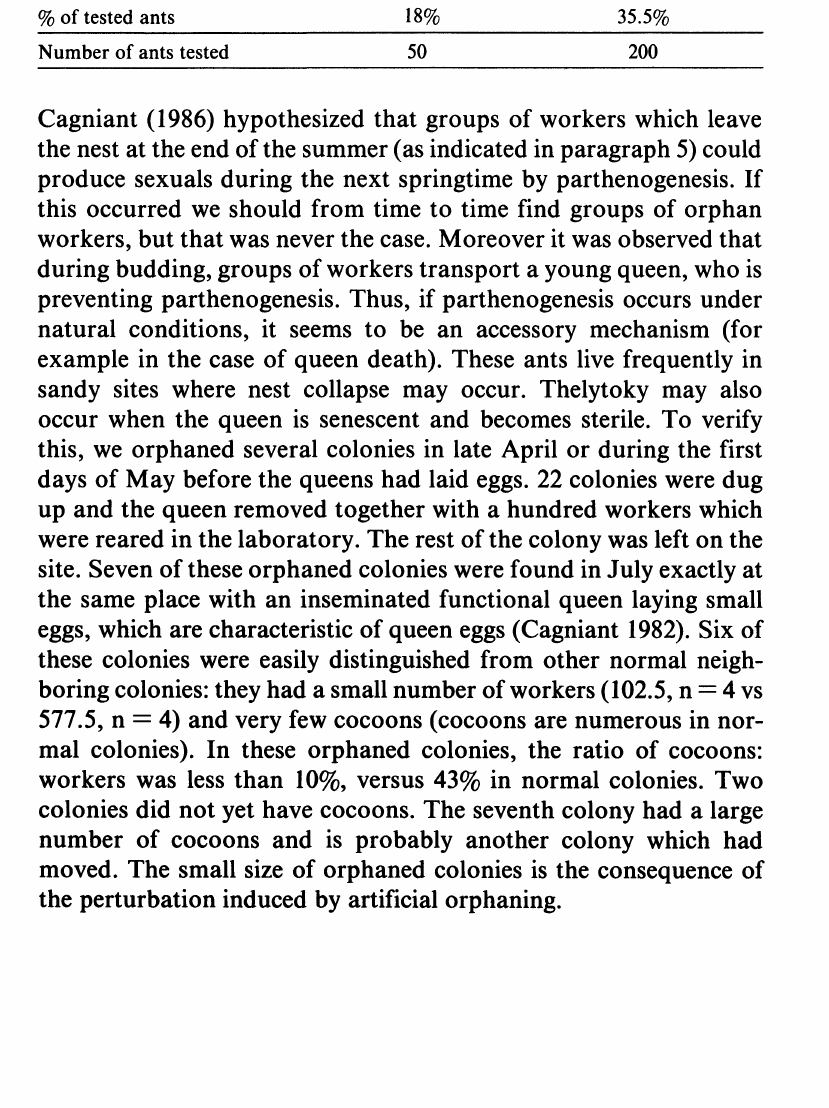
Psyche Control Alien